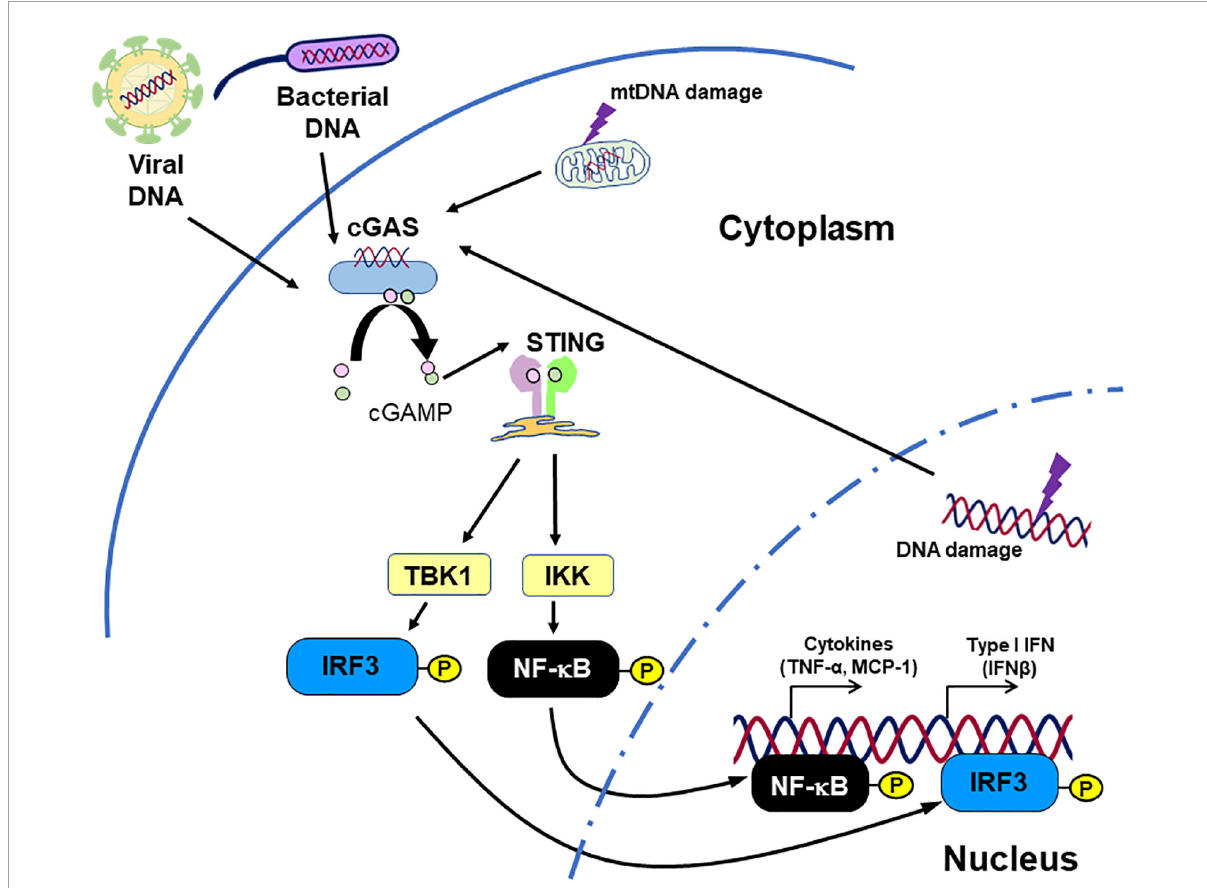
FIGURE2 Inflammation caused by STING. STING recognizes cGAMP, which originates from DNA fragments. Not only DNA fragments derived from pathogens, but also endogenous DNA fragments can activate STING signaling, promoting inflammatory responses. This figure is reproduced from Fukuda et al. (80) with